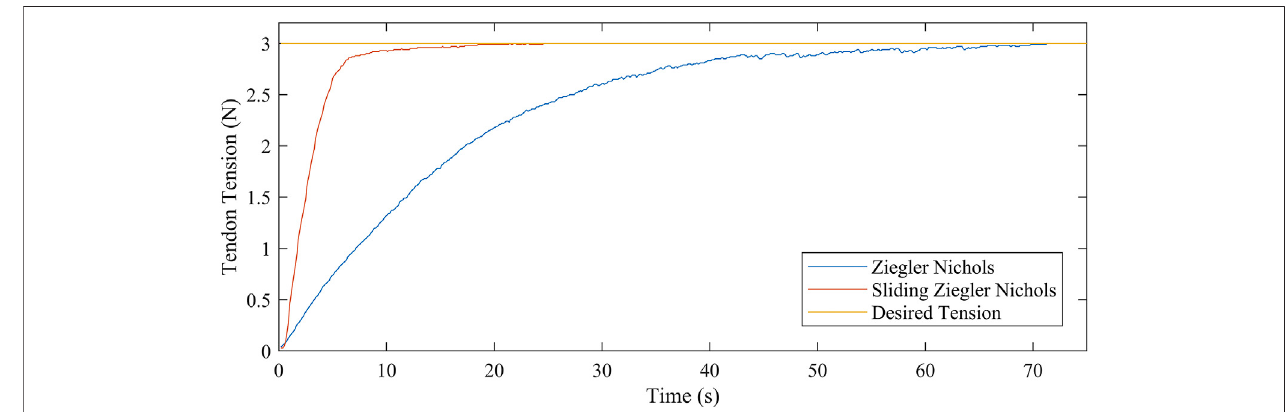
FIGURE 5 | Continuum robot control curves for two PID tuning techniques showing the tendon tension against